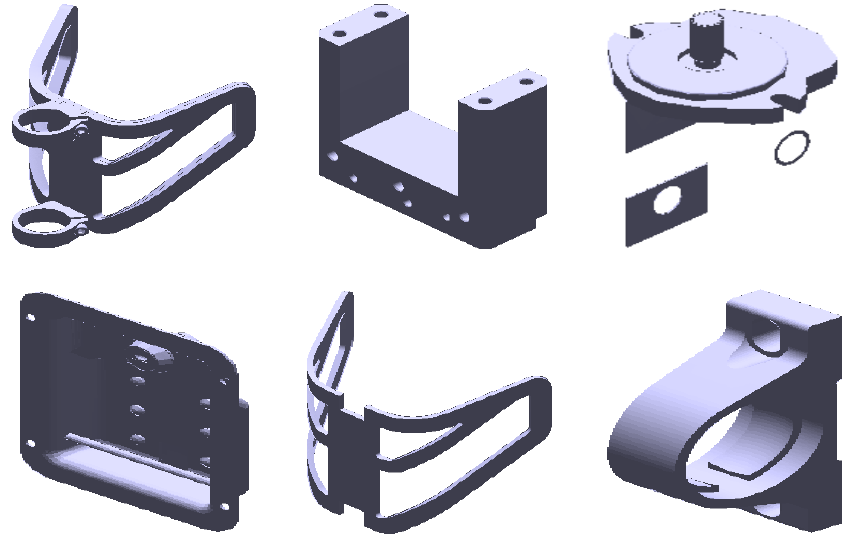
Figure 11. Collection of 6 models successfuly preselected by the hierarchical PCA at the second level, while the correct model was the very first one.